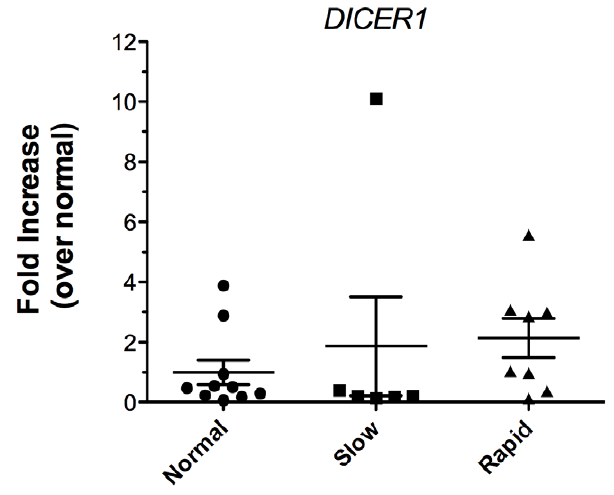
Figure 1. DICER1 expression does not differ between normal and IPF biopsies. Total RNA from SLBs was analyzed by qRT-PCR for transcript expression. Relative expression values were normalized to the normal group (n=10) and compared to the slowly progressive (n=6) or rapidly progressive group (n=9). Expression values were also normal- ized to GAPDH. Data are presented as mean 6 SE.